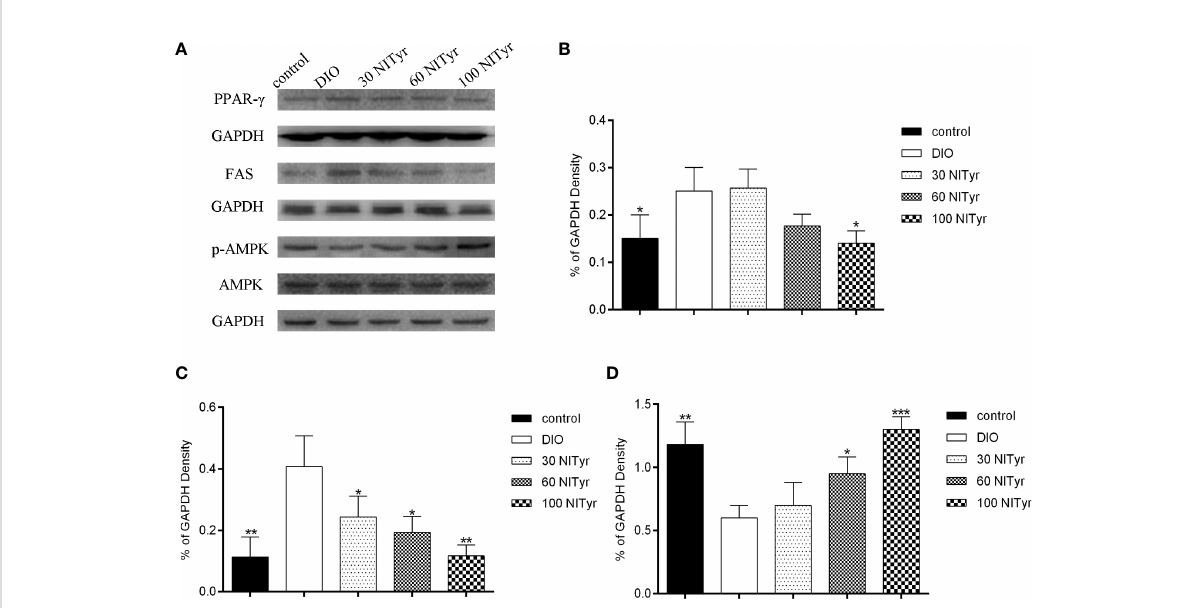
FIGURE 6 Effect of NITyr on the expression of key factors in adipogenesis. (A) Western blot analysis of PPAR- g , FAS and p-AMPK. (B) PPAR- g expressions were normalized that of GAPDH. (C) FAS expressions were normalized that of GAPDH. (D) p-AMPK expressions were normalized that of AMPK. The control or DIO group was treated with Poloxamer 188 aqueous solution. 30 NITyr, 60 NITyr and 100 NITyr were treated with 30 mg/kg NITyr, 60 mg/kg NITyr, 100 mg/kg NITyr, respectively. All values were expressed as means ± SD. (n = 3). * P < 0.05, ** P < 0.01, *** P < 0.001, as compared with the DIO group.